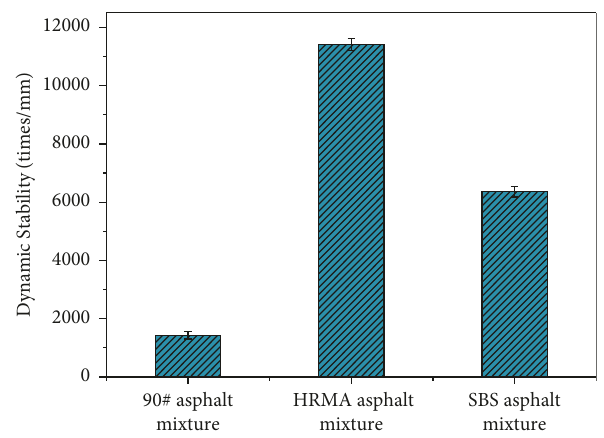
Figure 14: Dynamic stability of asphalt mixture. Table 5: Low-temperature performance of asphalt mixture. Mixture